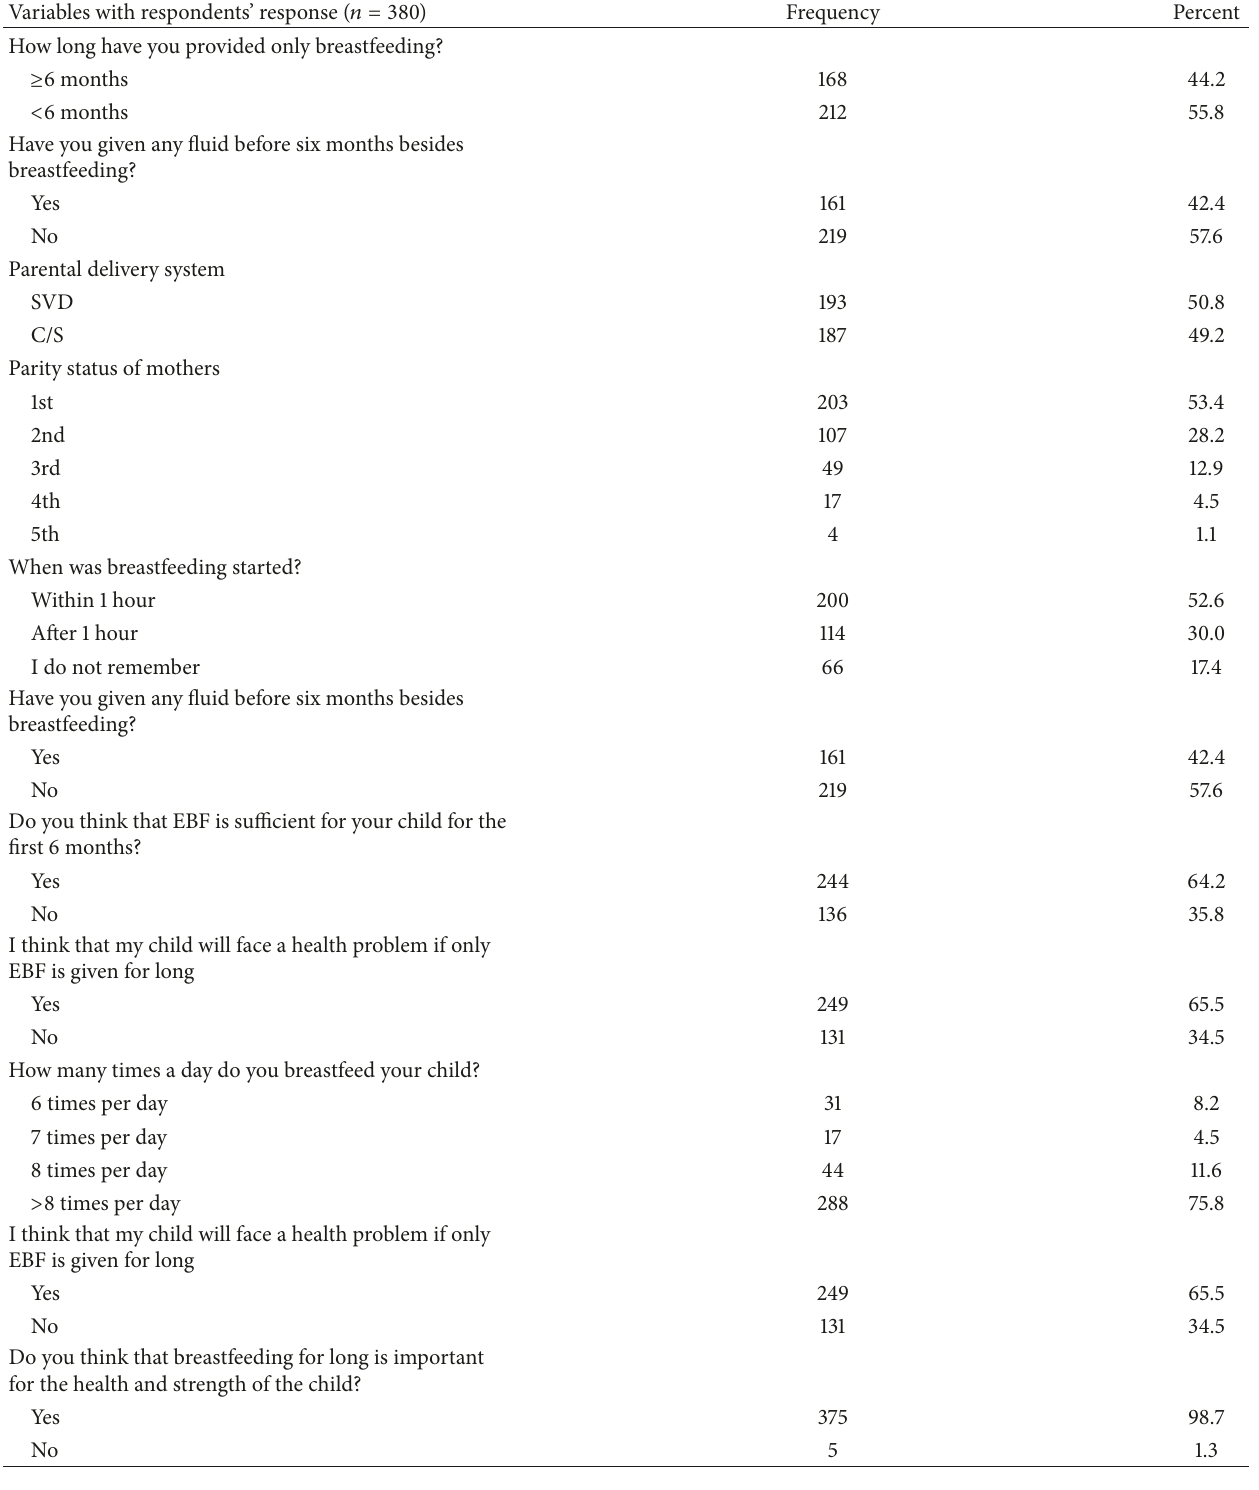
Table 3: Mothers’ experience of breastfeeding and giving supplementary foods practice of mothers attending private pediatric clinics,